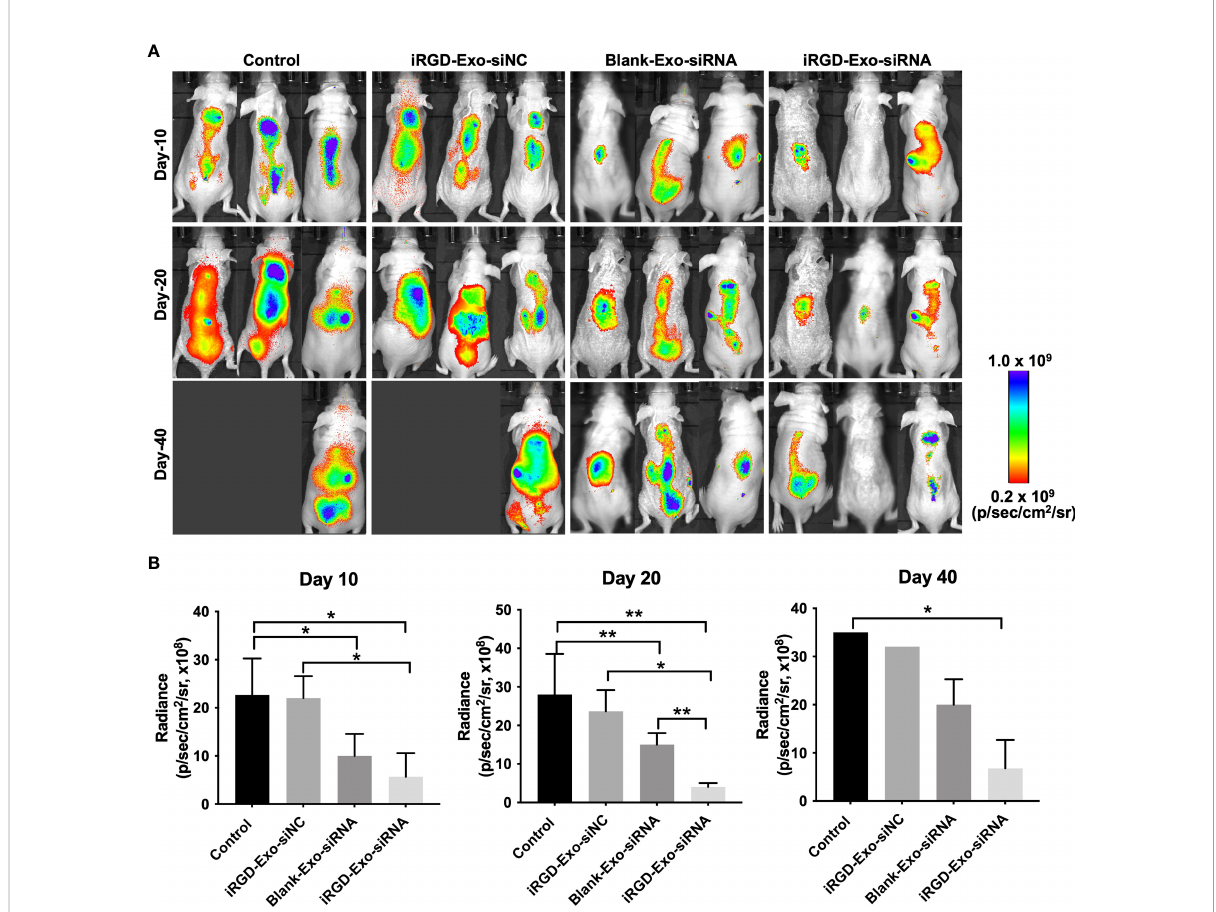
FIGURE 6 In vivo antitumor effect of iRGD-Exos-BCL6 siRNA. (A, B) Fire fl y luciferase expressing OCI-Ly8 cells were injected into the nude mice via tail vein, and then mice were intravenously injected with PBS, iRGD-Exo-siNC, blank-Exo-BCL6 siRNA (blank-Exo-siRNA) and iRGD-Exo-BCL6 siRNA (iRGD-Exo-siRNA). Luciferase activity at days 10, 20 and 40 after cancer cell injection was detected. *P < 0.05, **P <